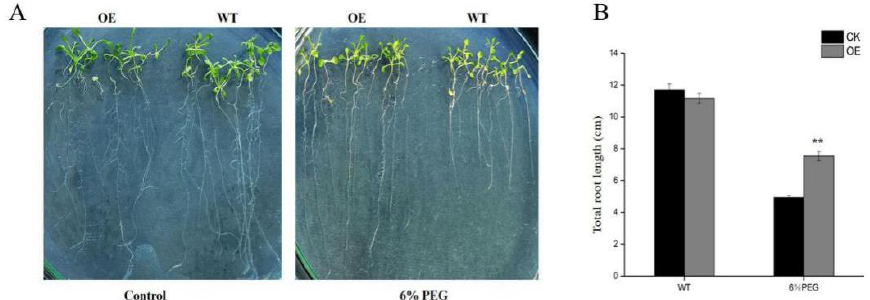
Figure 7. Total root lengths of transgenic Arabidopsis lines under mock drought stress. Phenotypes of WT and TaGApC2-6D transgenic Arabidopsis seedlings under 1/2 MS medium with or without 6% PEG8000. ( A ) Root lengths phenotype of WT and TaGApC2-6D transgenic Arabidopsis seedlings grown on 1/2 MS medium with or without 6% PEG8000 for seven days. ( B ) Root lengths of WT and TaGApC2-6D transgenic Arabidopsis seedlings grown on 1/2 MS medium with or without 6% PEG8000 for seven days. Data are means±SD of three independent experiments, and asterisks indicate a significant difference between WT and transgenic Arabidopsis lines (** p < 0.01).